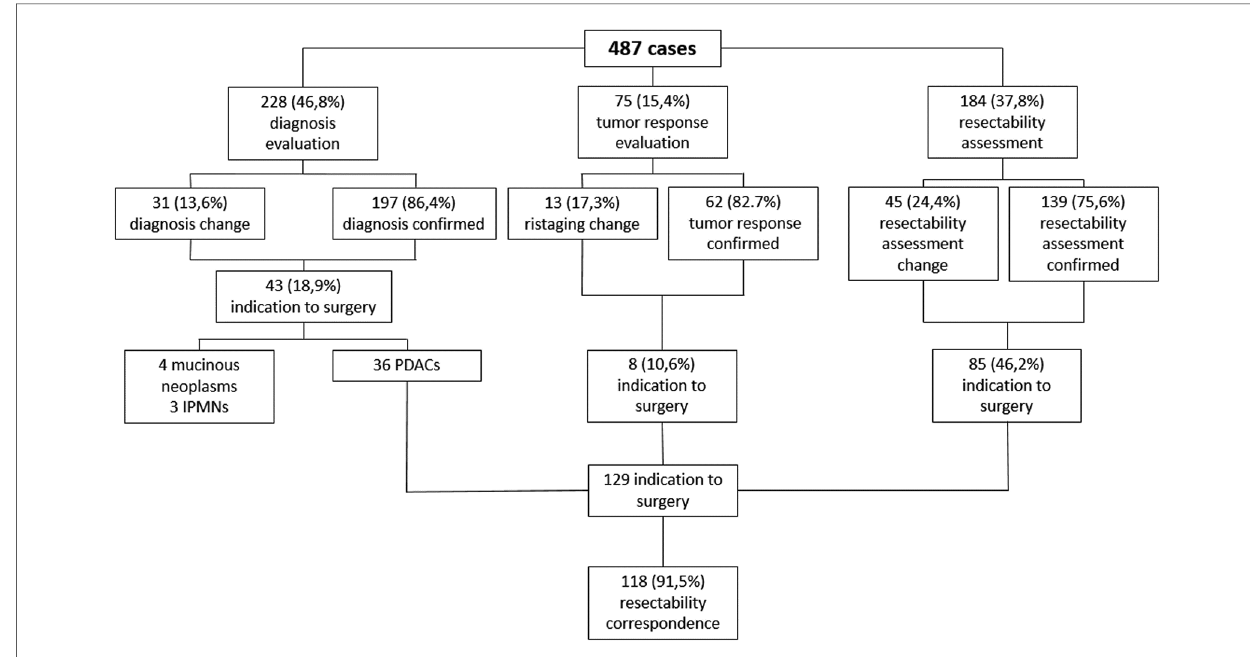
FIGURE 4 Diagram of the MDTB management and